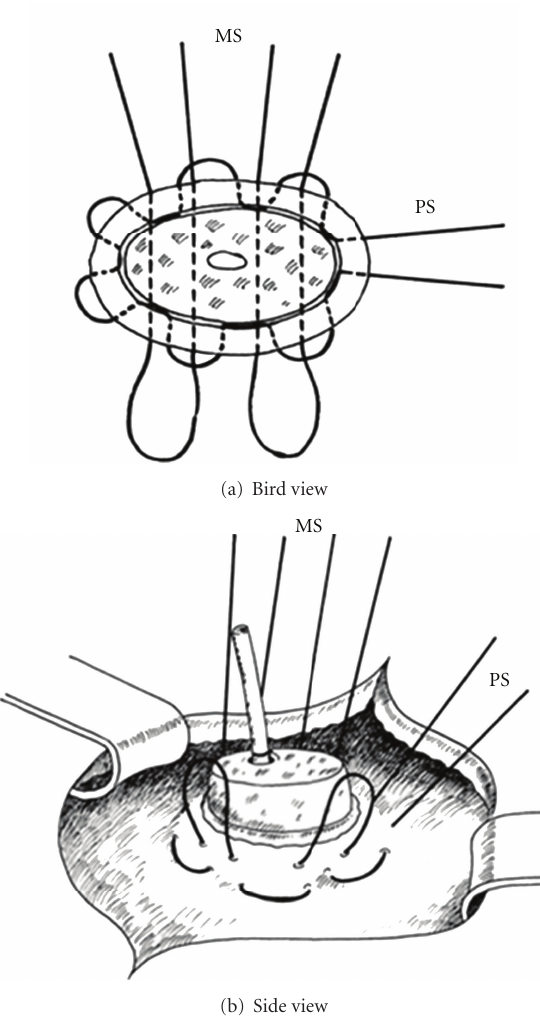
Figure 4: Scheme of the 2 mattress sutures running through the posterior gastric wall and the pancreatic remnant in an U-like fashion, while the purse-string suture is already in place. PS: purse- string suture; MS: mattress